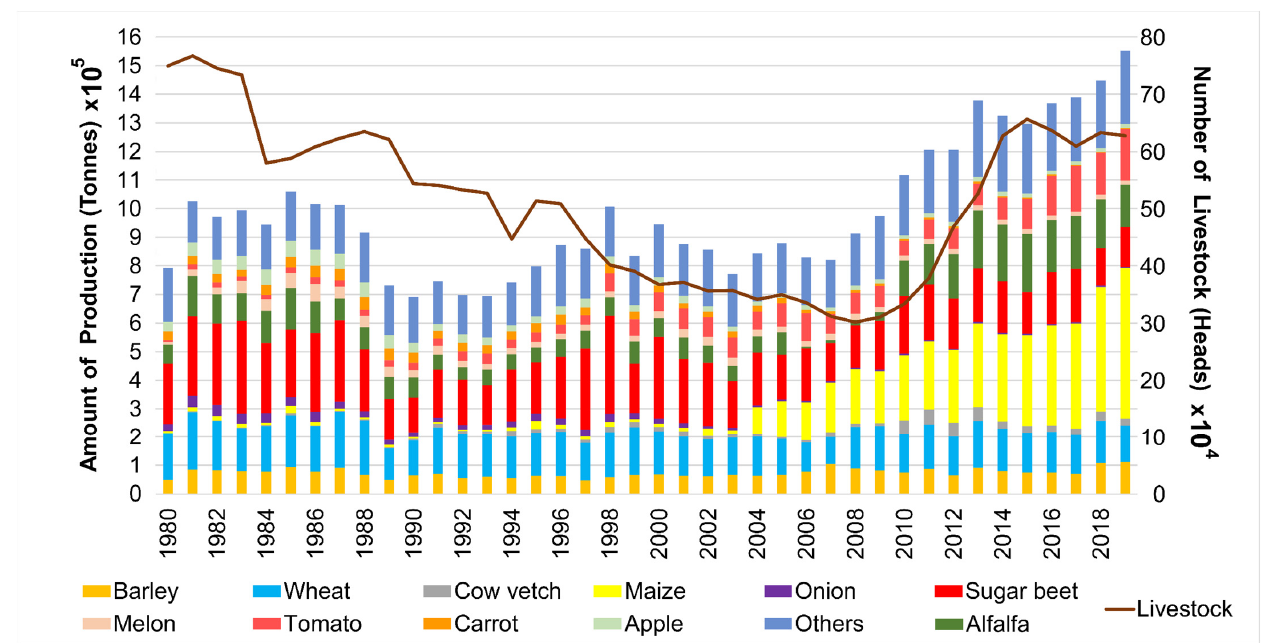
Figure 2. Total agricultural products (tons) and number of livestock (heads) in the Burdur sub-basin between 1980 and 2019 (from TÜ İ K 2020).